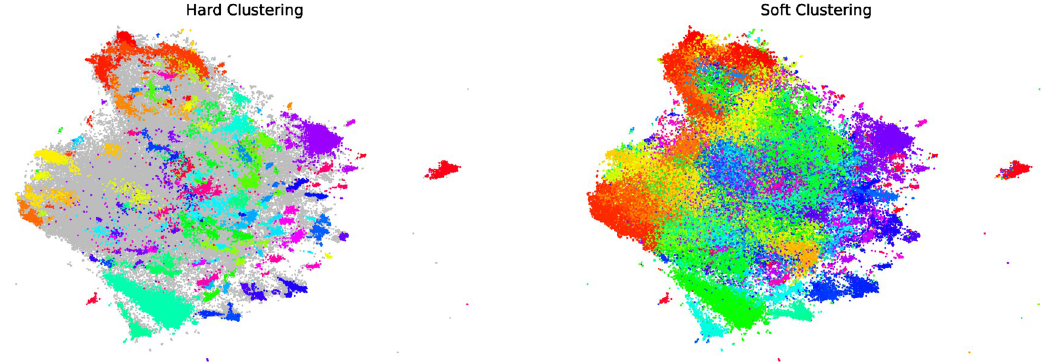
Fig 9. 2D visualization of the HDBSCAN results on the journalists dataset with both hard and soft clustering. 265 clusters are found (they are the same in both cases). In the first case, each point is classified as either belonging to a single cluster (colored points) or as an outlier (grey point), whereas in the second case each point is assigned a likelihood to belong to each cluster (the points take the color of the cluster they belong to most